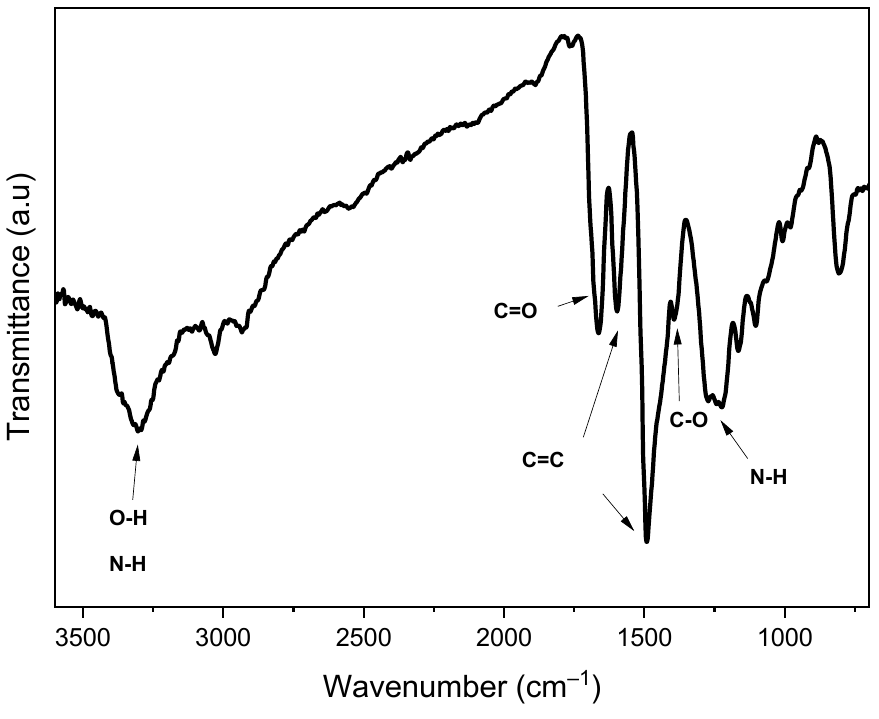
Figure 5. FTIR spectrum of rGO-PANI film.